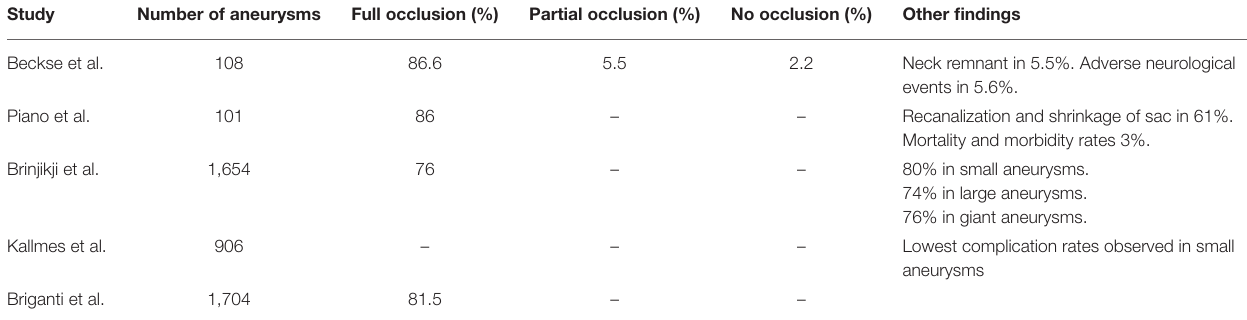
TABLE 2 | Summary of occlusion outcomes for flow diversion